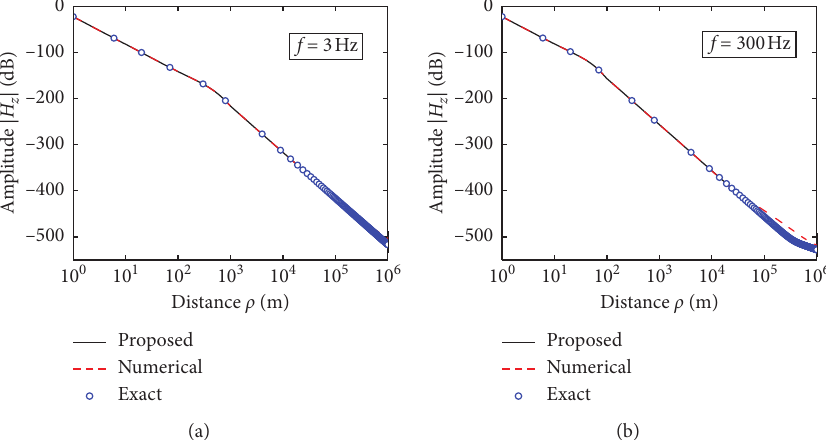
Figure 4: Amplitudes and phase angles of the field component H solutions. (a, c) f � 3 Hz. (b, d) f � 300